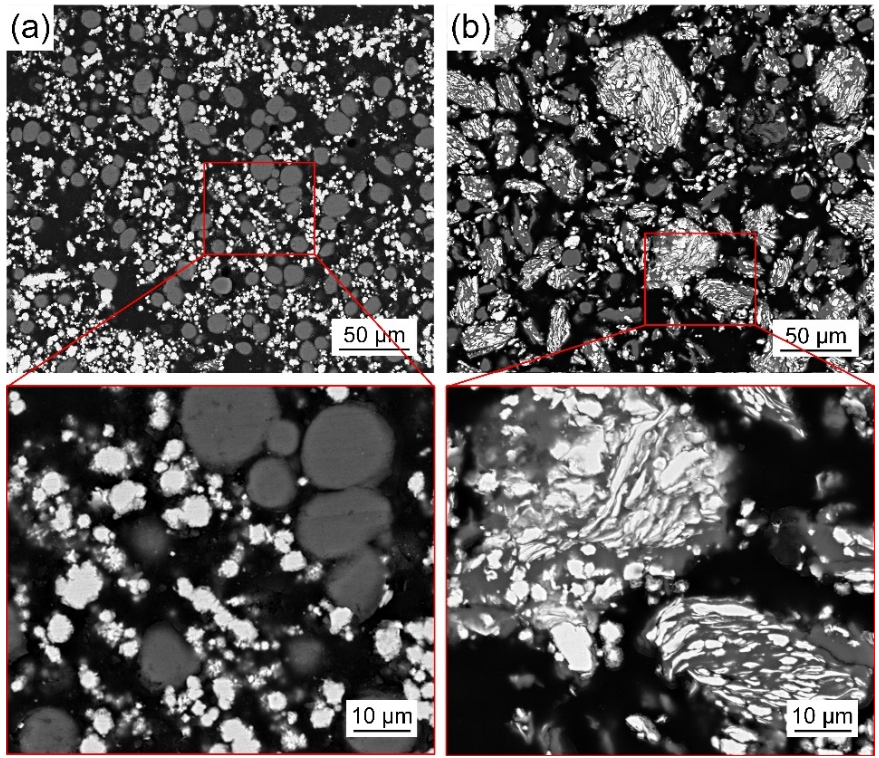
Figure 3. Microstructure of Al/Ni energetic composites ( a ) before and ( b ) after ball milling.